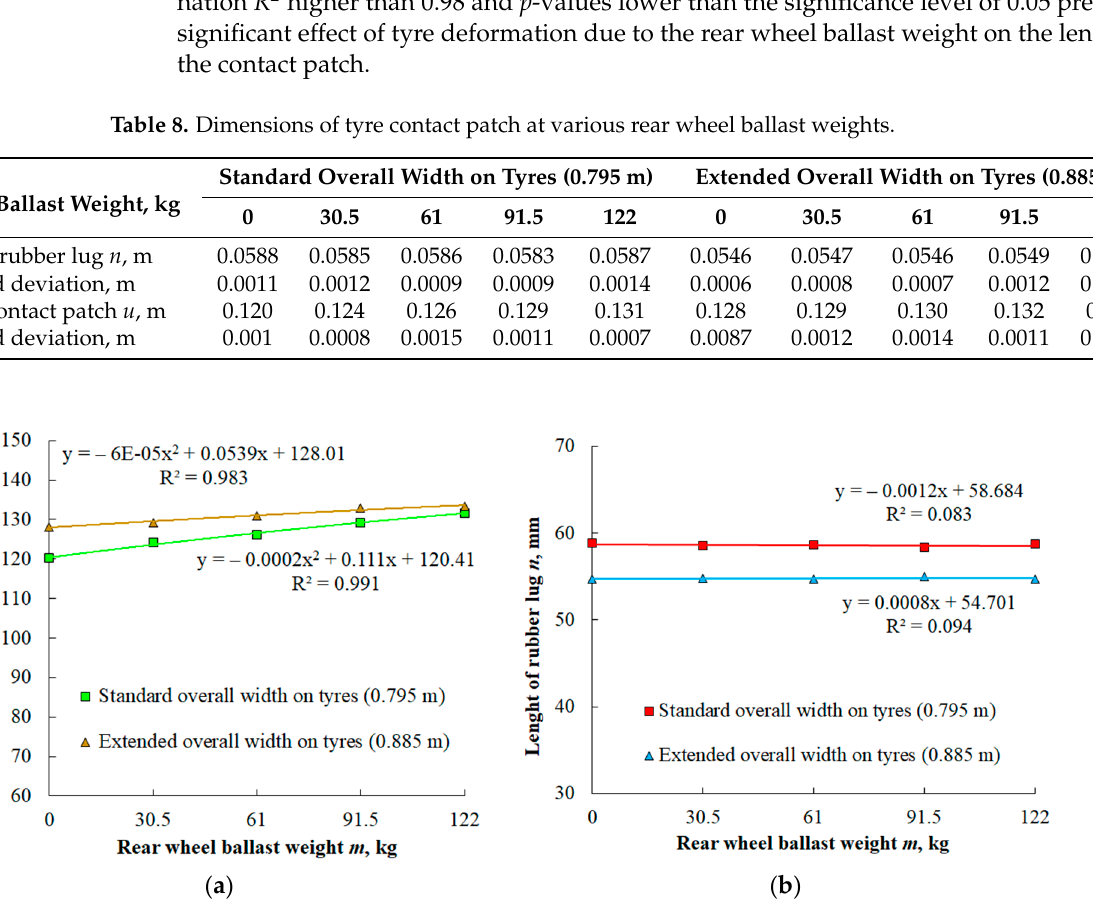
Figure 13. Dimensions of tyre contact patch: ( a ) length of contact patch, ( b ) length of rubber lug.